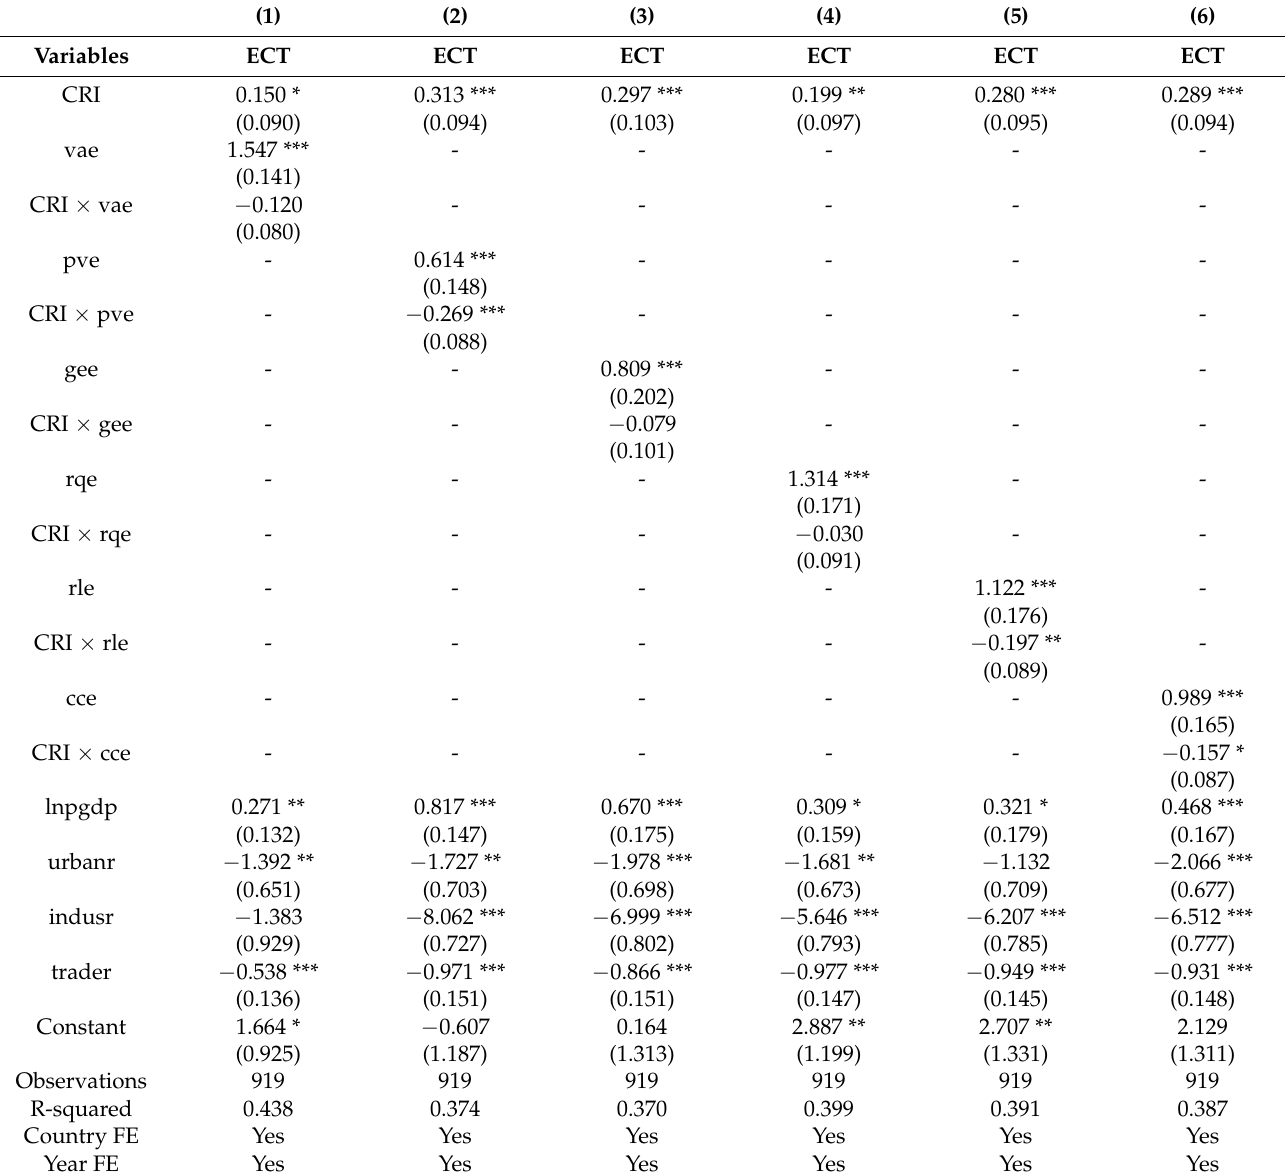
Table 6. Estimation results of the moderating effect of governance